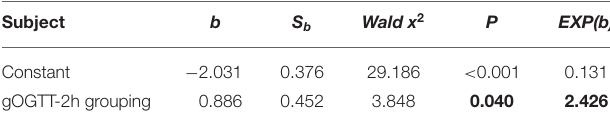
TABLE 5 | The relationship between gOGTT-2hPG and ppOGTT ( n =